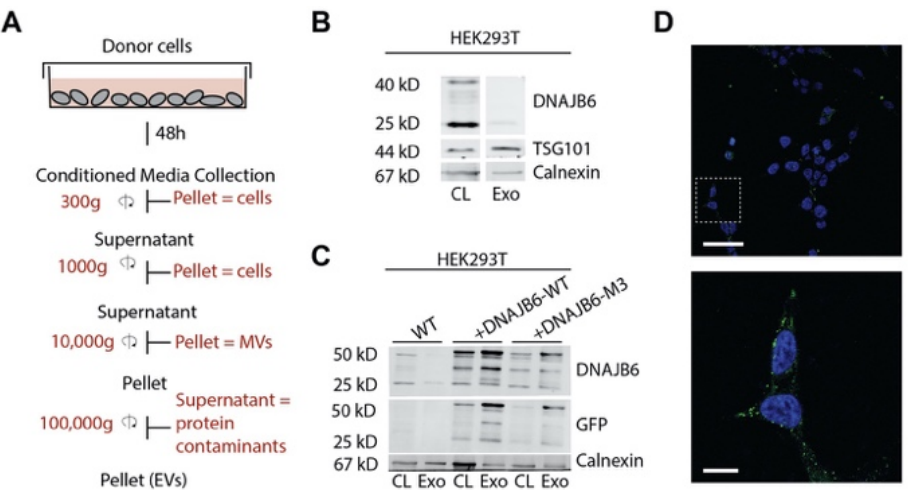
Figure 2. DNAJB6 ‐ WT ‐ and DNAJB6 ‐ M3 ‐ expressing HEK293T cells release exosomes that contain DNAJB6 ‐ WT and DNAJB6 ‐ M3, respectively. ( A ) Exosome isolation workflow from cell culture media of donor cells. ( B ) Western blot analysis of exosomes isolated from HEK293T cells for DNAJB6, exosome marker TSG101, and non-marker Calnexin protein levels. CL: cell lysate, Exo: exosome lysate. ( C ) Western blot analysis of exosomes isolated from HEK293T WT, DNAJB6-WT, and DNAJB6-M3 for DNAJB6, GFP, and Calnexin protein levels. DNAJB6A: 40 kDa, DNAJB6B: 25 kDa, GFP-DNAJB6(-M3): 50 kDa. ( D ) Representative image of DNAJB6-WT exosome uptake in HEK293T recipient cells (t = 24 h).